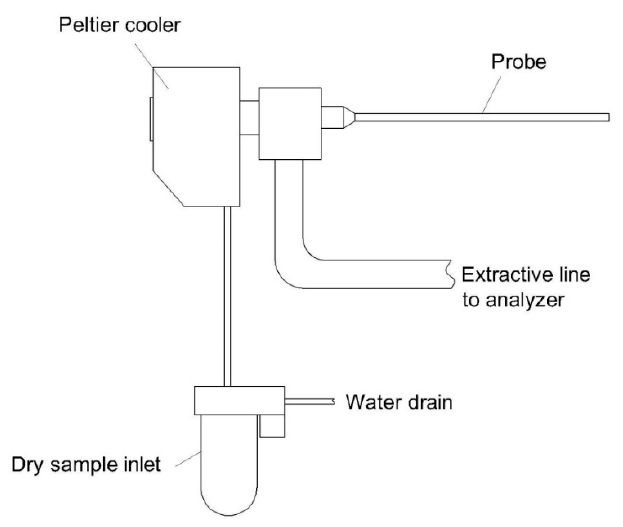
Figure 5. Schematic diagram of a sampling probe coupled with a Peltier cooler [71].